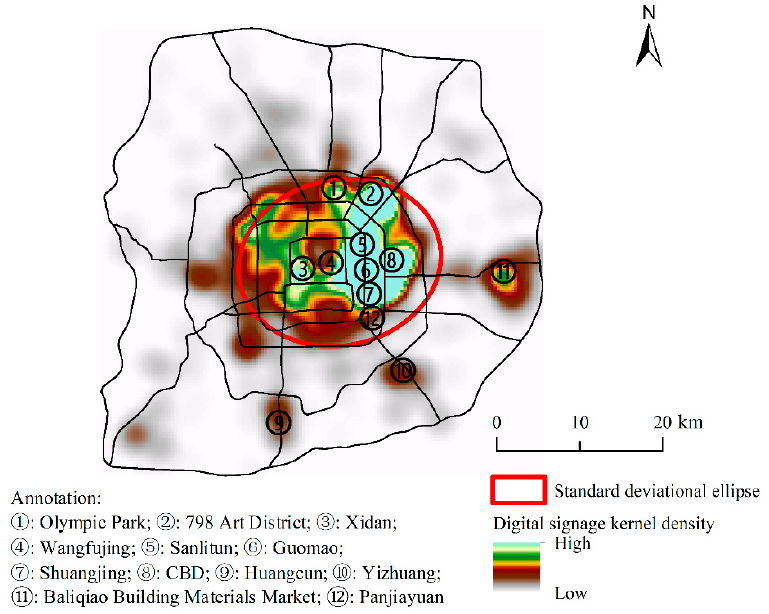
Figure 3. Kernel density and standard deviational ellipse analysis of digital signage.